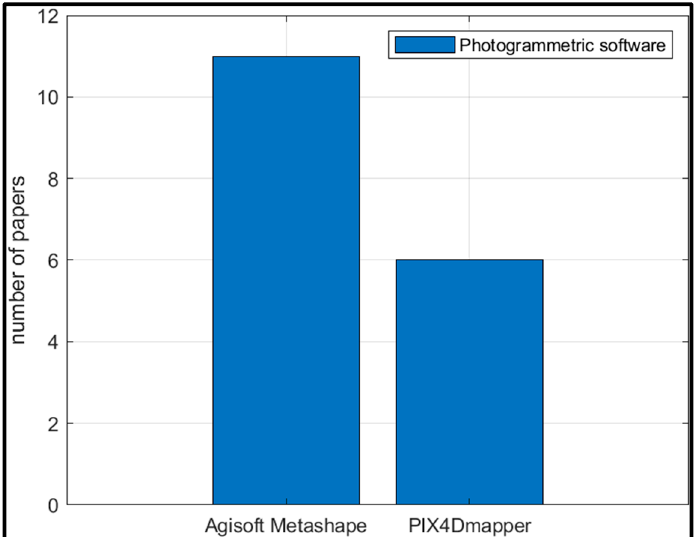
Figure 5. Photogrammetric software employed for the extraction of DEM/DSM/point clouds/ortho-